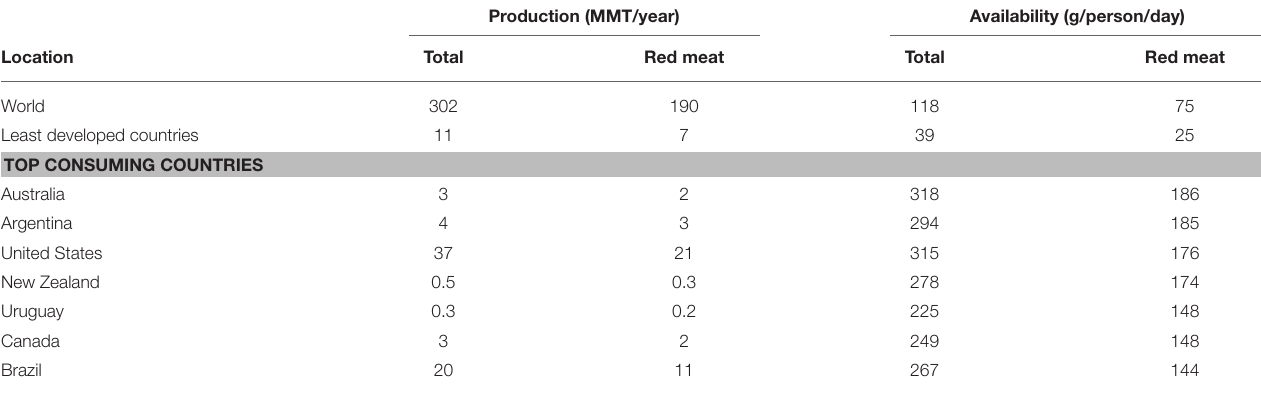
TABLE 1 | Average annual production of total meat and red meat only (bovine, pork, mutton, and goat), and its estimated contribution per capita during 2013